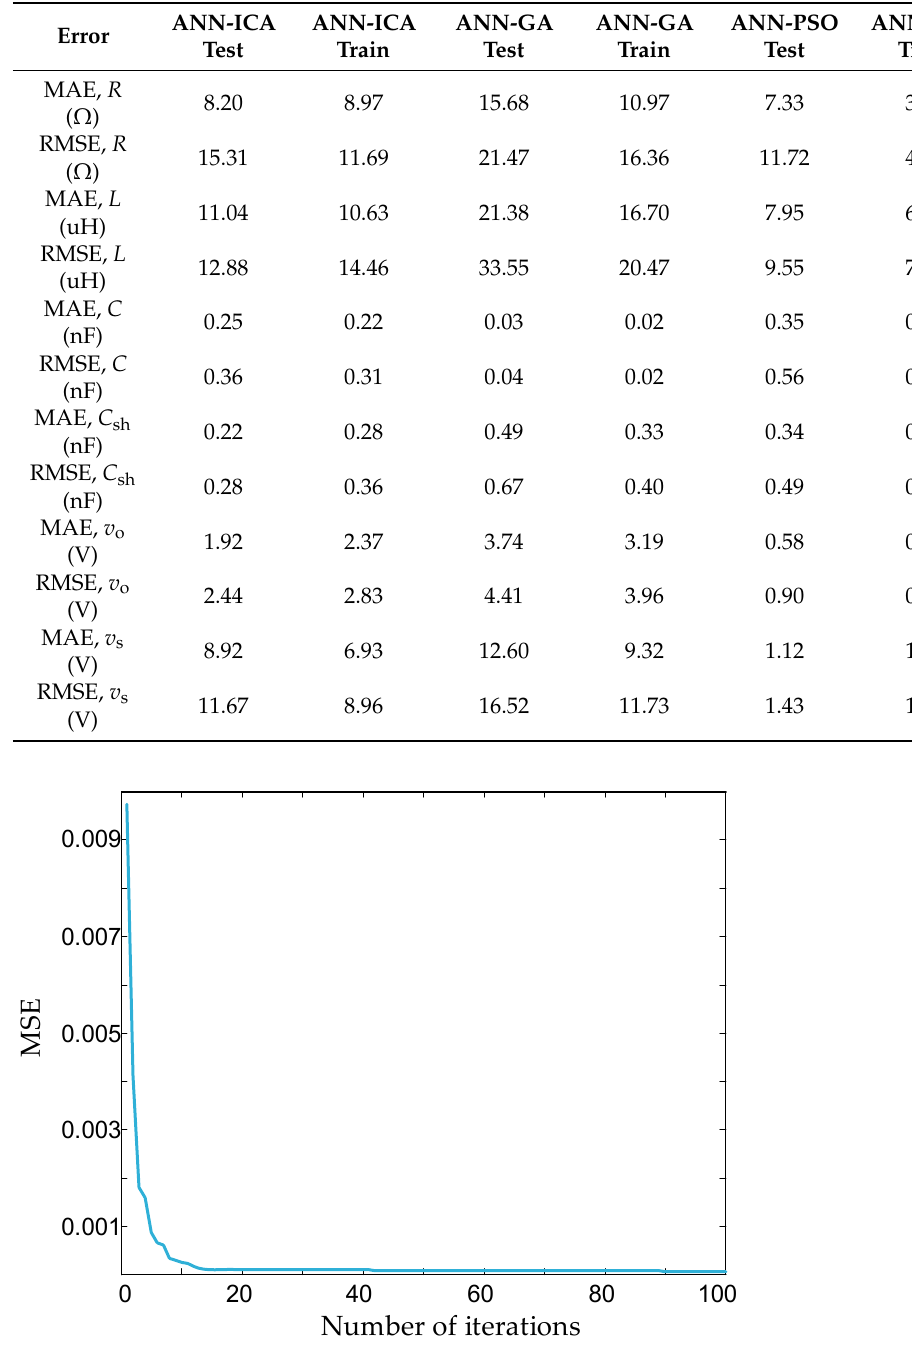
Table 4. Summary of the results of the initial hybrid ANN-optimization networks.